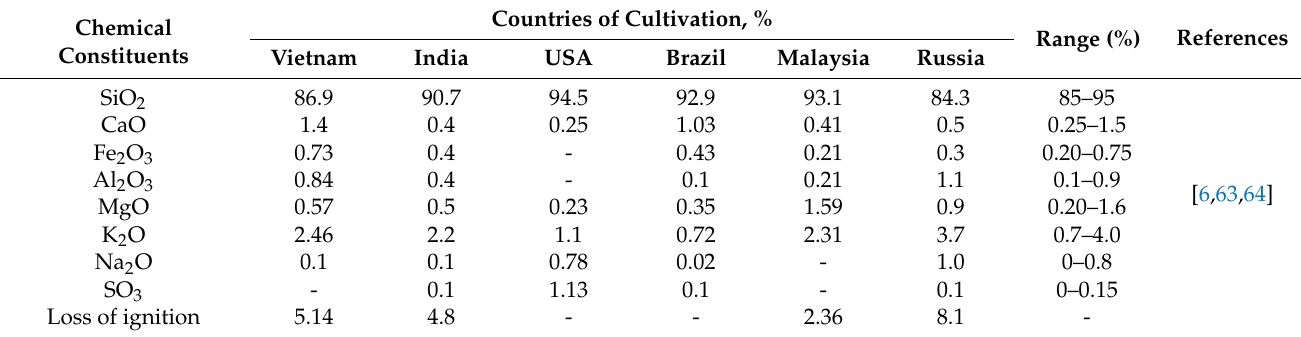
Table 3. The oxide content of the RHA by regions of